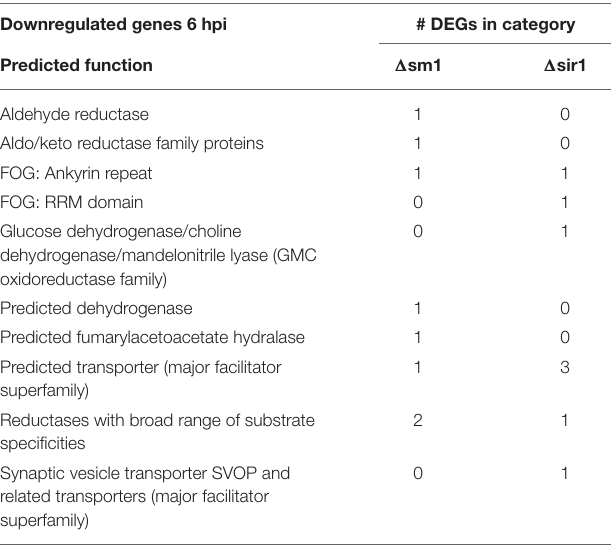
TABLE 2 | Downregulated genes with general function KOGG annotation in 1 sm1 or 1 sir1 at 6 hpi. Downregulated genes 6 hpi